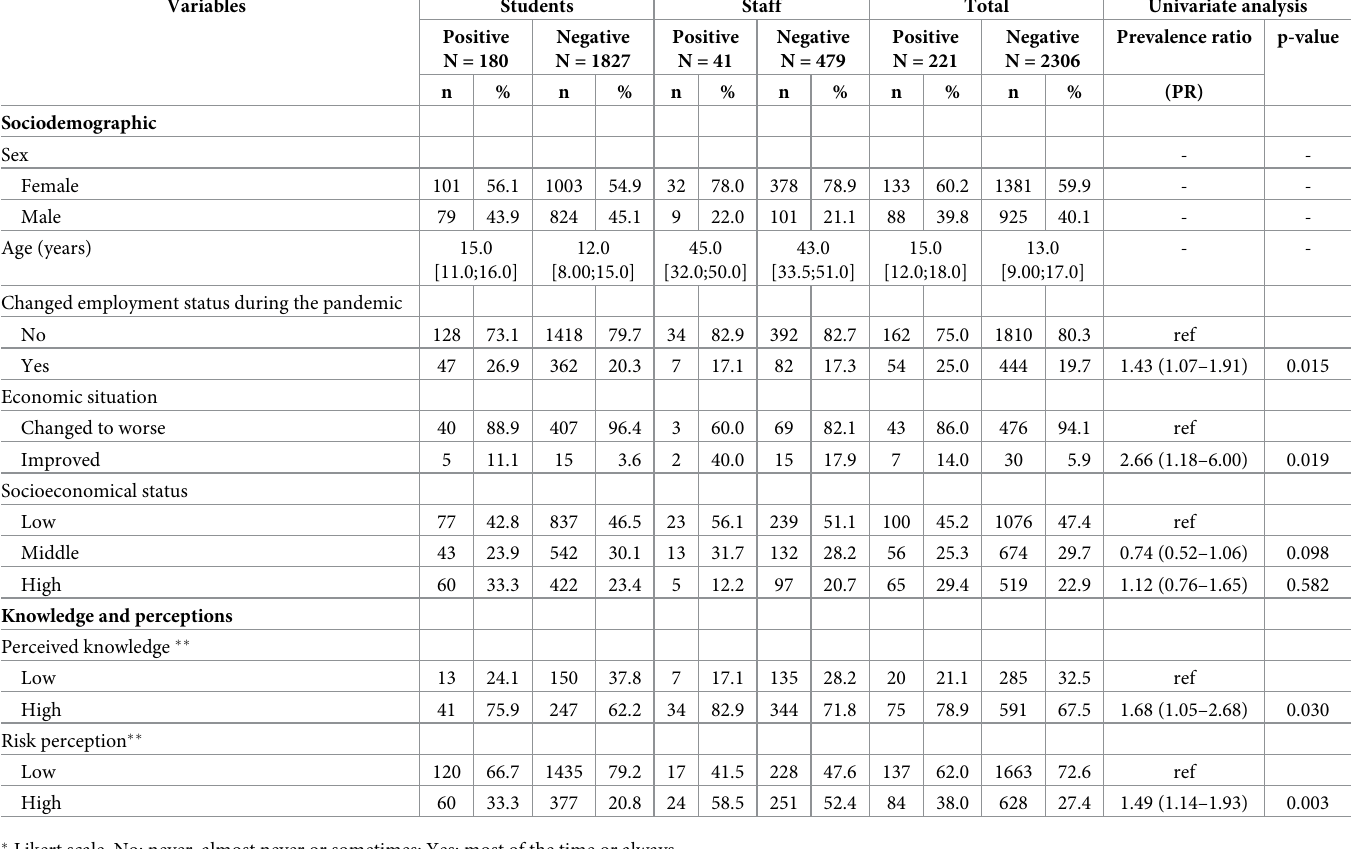
Table 6. Summary and univariate analysis between SARS-CoV-2 infection and sociodemographic, health and behavioral indicators of students and staff from senti- nel schools. Catalonia, February to March 2021. Variables